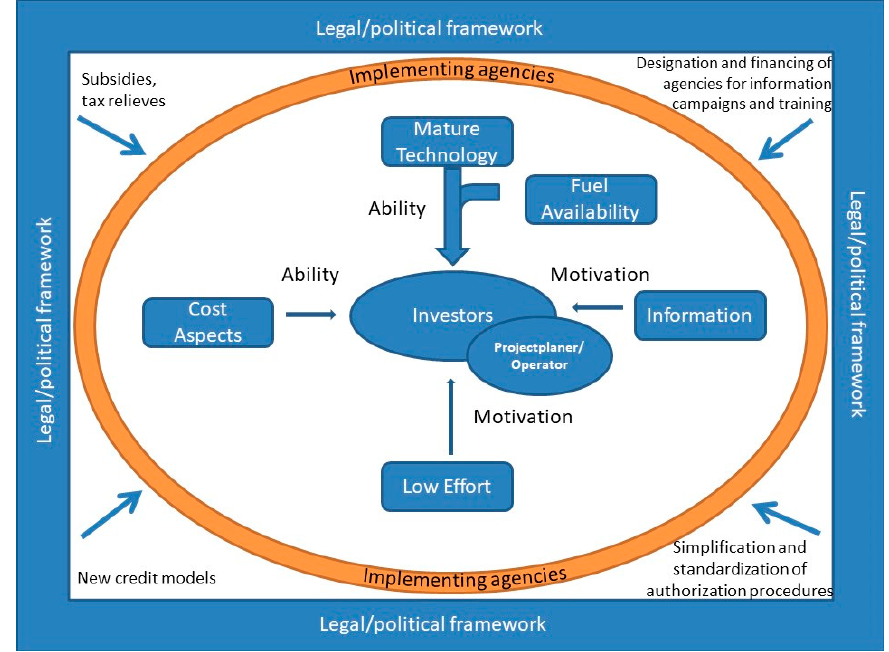
Figure 4. The system supporting the implementation of biomass for heat technologies (source: own illustration, based on [28] modified from [29].